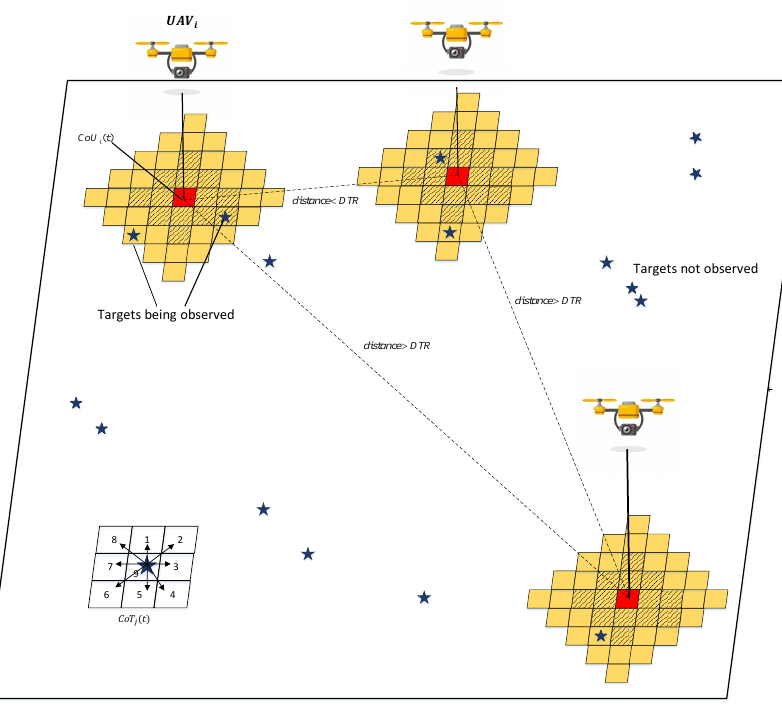
Figure 2. UAVs and targets (stars) are moving in a bounded area that is partitioned into cells; CoU i ( t ) and CoT j ( t ) represent the locations of UAV i and target j at time t , respectively; the yellow shaded areas denote the FOV (field of view) of each UAV when SR = 4 while the slash shaded areas represent the movement choices for each UAV at the next time step; UAVs can communicate with each other within data transmission range DTR